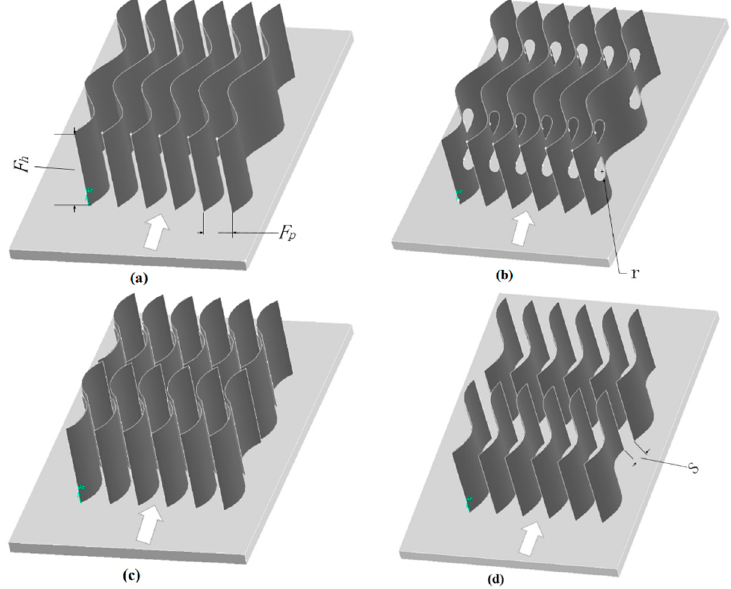
Figure 1. The shape of ( a ) traditional wavy fin; ( b ) perforated wavy fin; ( c ) staggered wavy fin; ( d ) discontinuous wavy fin.